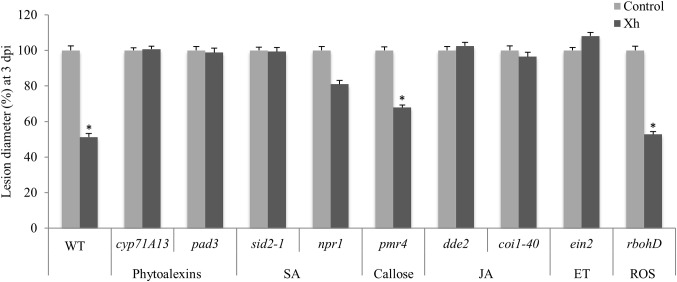
Characterization of defense pathways triggered during Xh-induced resistance against B. cinerea using Arabidopsis mutants. Two days after treatment with Xh (2.5 mg/ml) or water (control), mutants disrupted in the production of phytoalexin (cyp71A13, pad3), salicylate (sid2-1, npr1), jasmonate (dde2, coi1-40), ethylene (ein2), callose (pmr4), or reactive oxygen species (rbohD) were inoculated with B. cinerea (5.104 conidia ml-1) and disease symptoms were measured at 3 dpi. Histograms represent the mean lesion diameter ± SE of three independent experiments (n = 60). Data are expressed as percentage of the water-treated control, set as 100%. Asterisks indicate statistically significant differences between control and elicitor-treated plants using a Student’s t-test (P < 0.05).